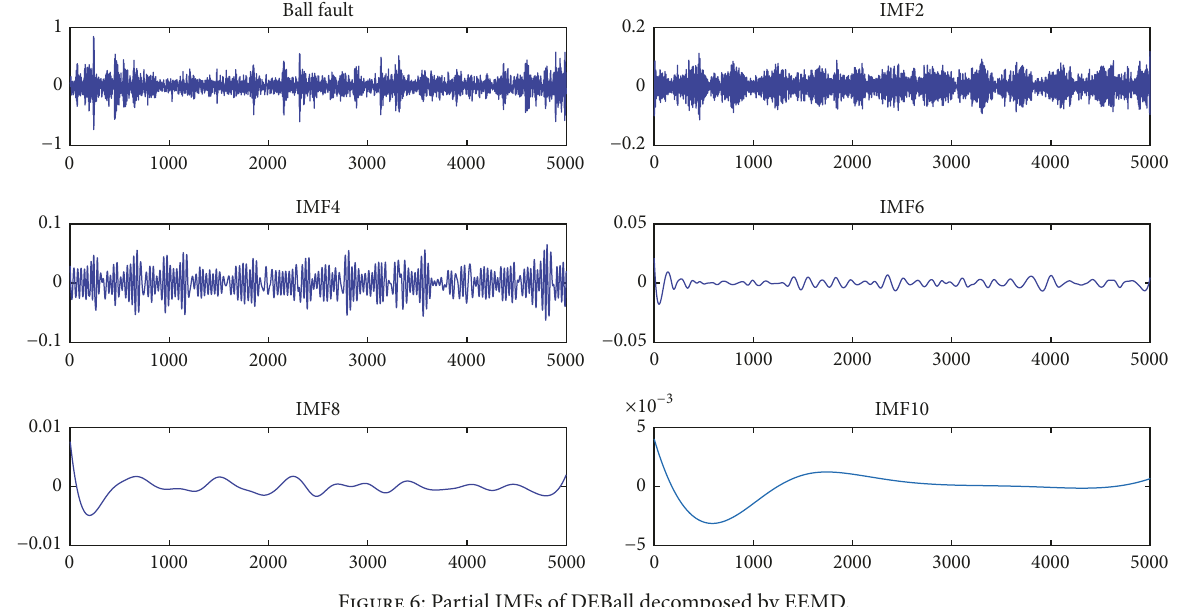
Figure 6: Partial IMFs of DEBall decomposed by EEMD. Table 1: The correlation coefficient between each IMF and unresolved signals.